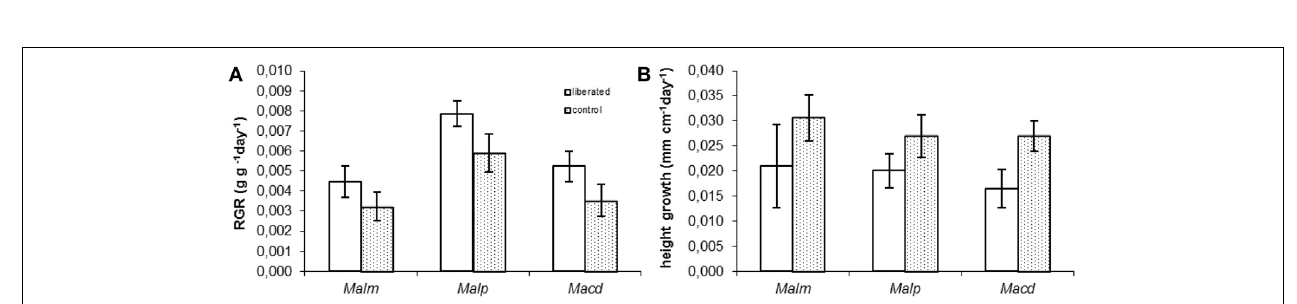
FIGURE 4 | (A,B) Measured above ground Relative Growth Rate (RGR) and relative height growth rate of control and liberated plants in 174 days after vegetation removal (gap radius = 0.5m). For abbreviations see Figure 3 . Bars denote standard